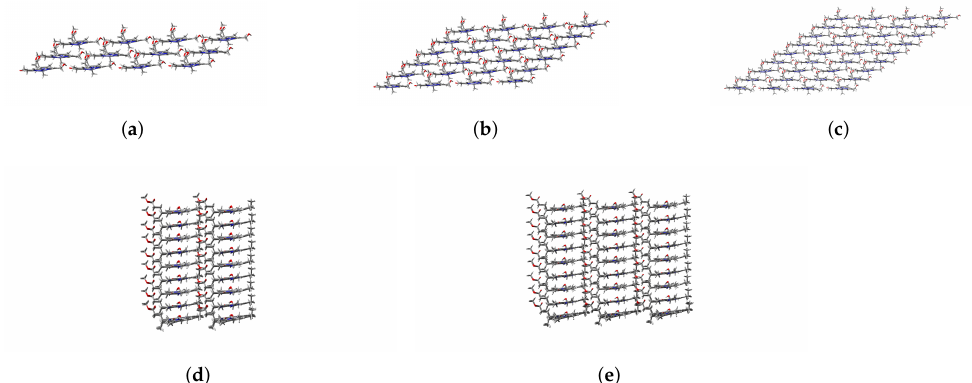
Figure 7. Main views of ( a ) Zn12, ( b ) Zn24, and ( c ) Zn36 and left side views of ( d ) Zn72 and ( e ) Zn108.